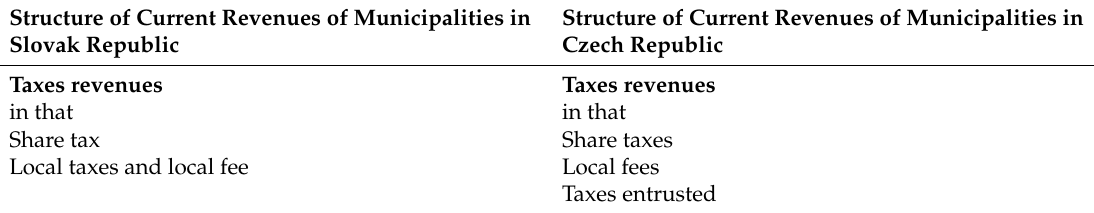
Table 3. The structure of current revenues of municipalities in Slovak Republic and in Czech Republic. Structure of Current Revenues of Municipalities